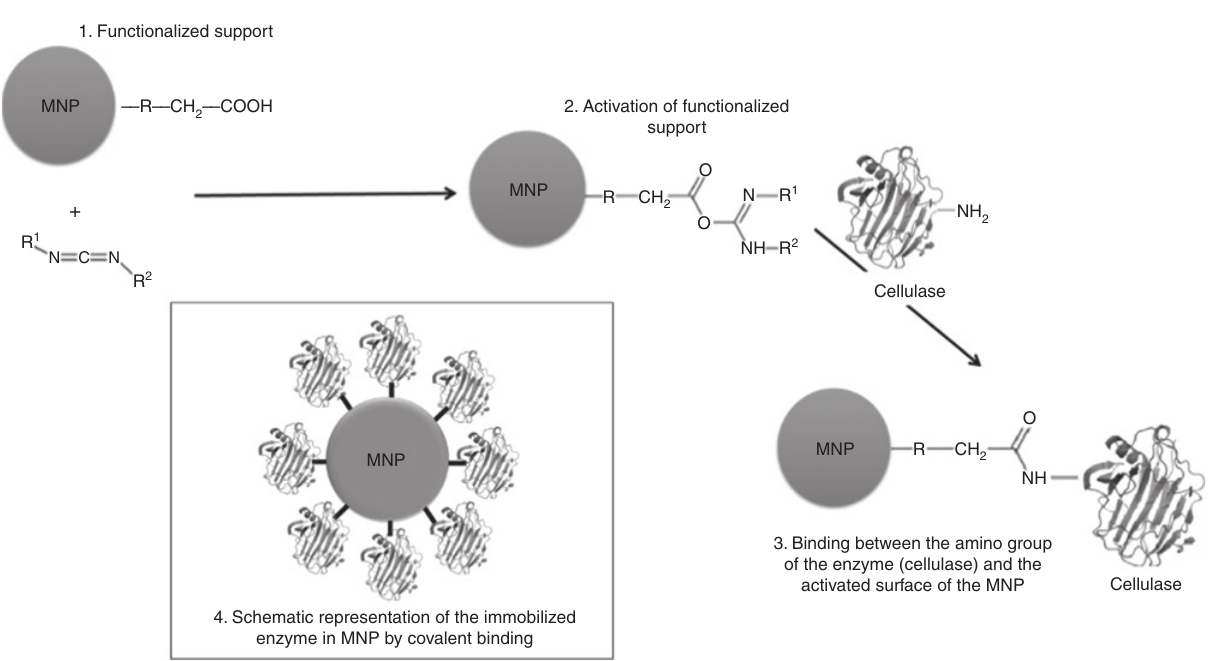
Figure 3: Possible mechanism for MNP activation using carbodiimides [78, 86].